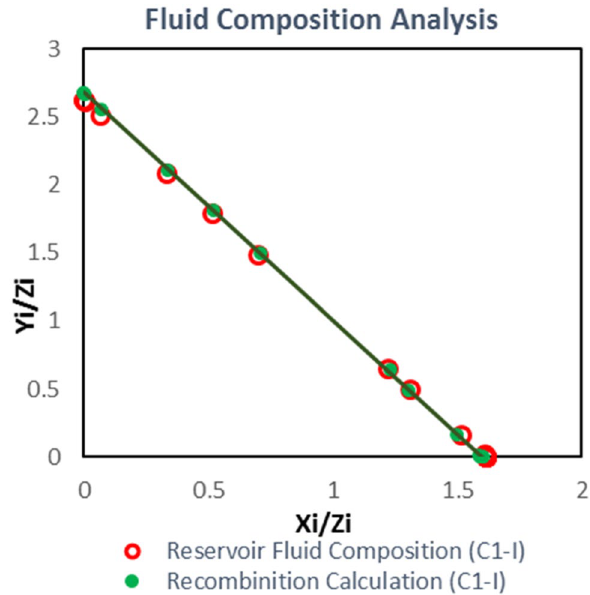
Fig. 15 Reliable fluid sample compositions—recombination test